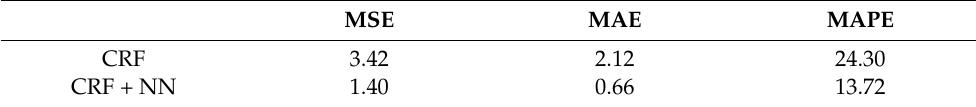
Table 8. Prediction and evaluation results of curvature radius after springback in variable-curvature roll bending based on conditional random field.